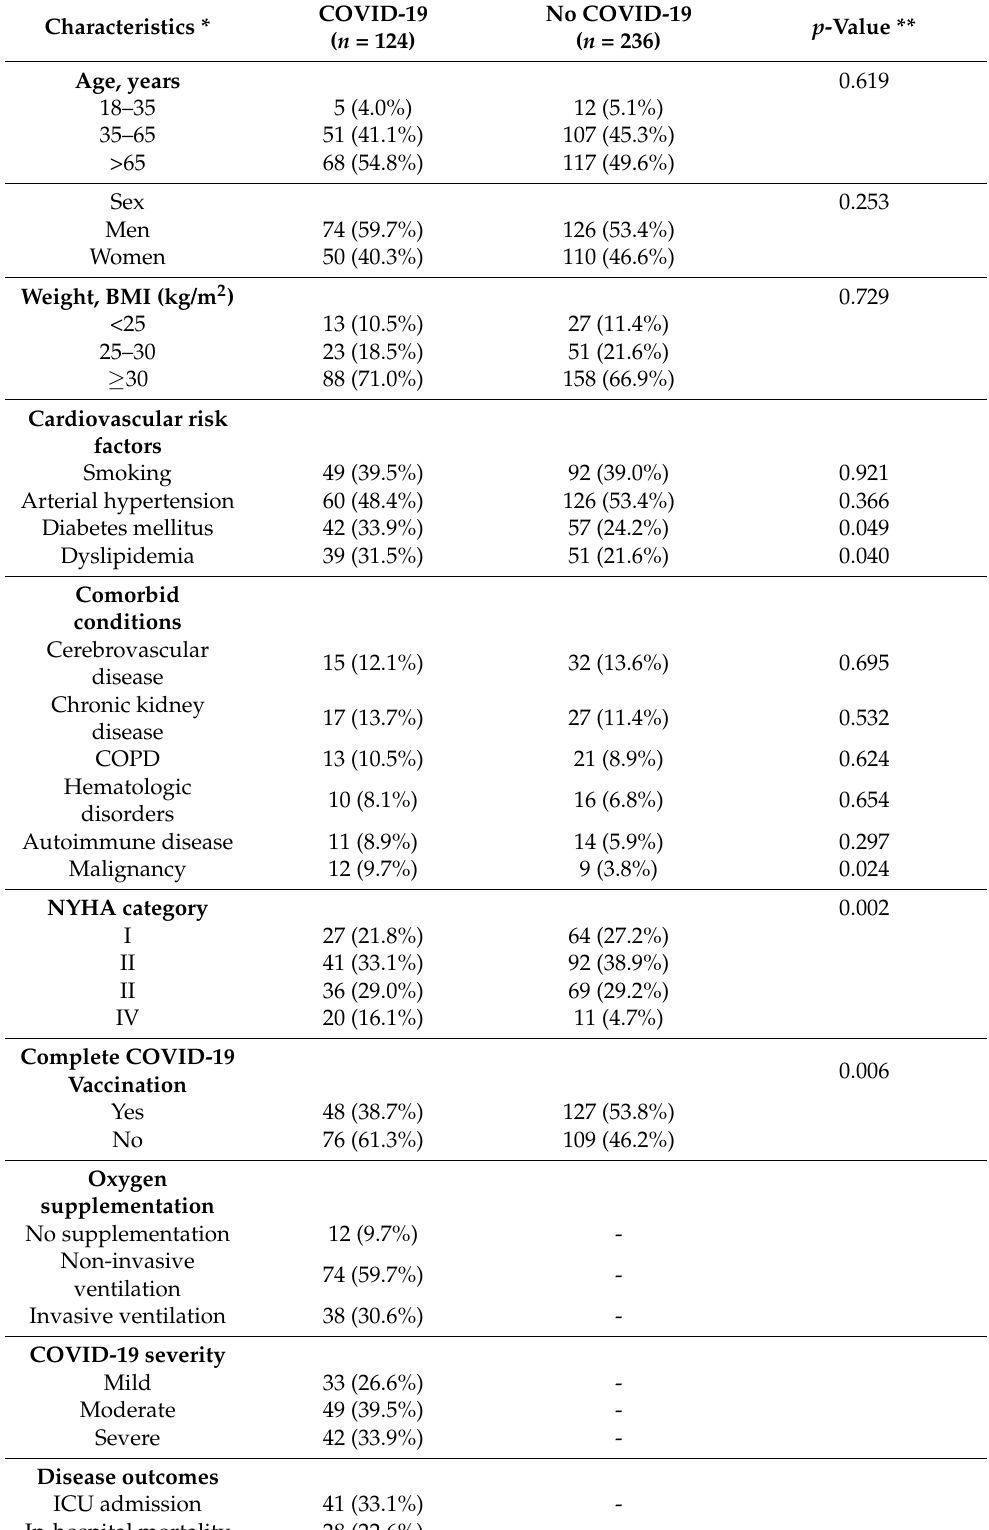
Table 1. Background characteristics of heart failure patients stratified by SARS-CoV-2 infection status. Characteristics